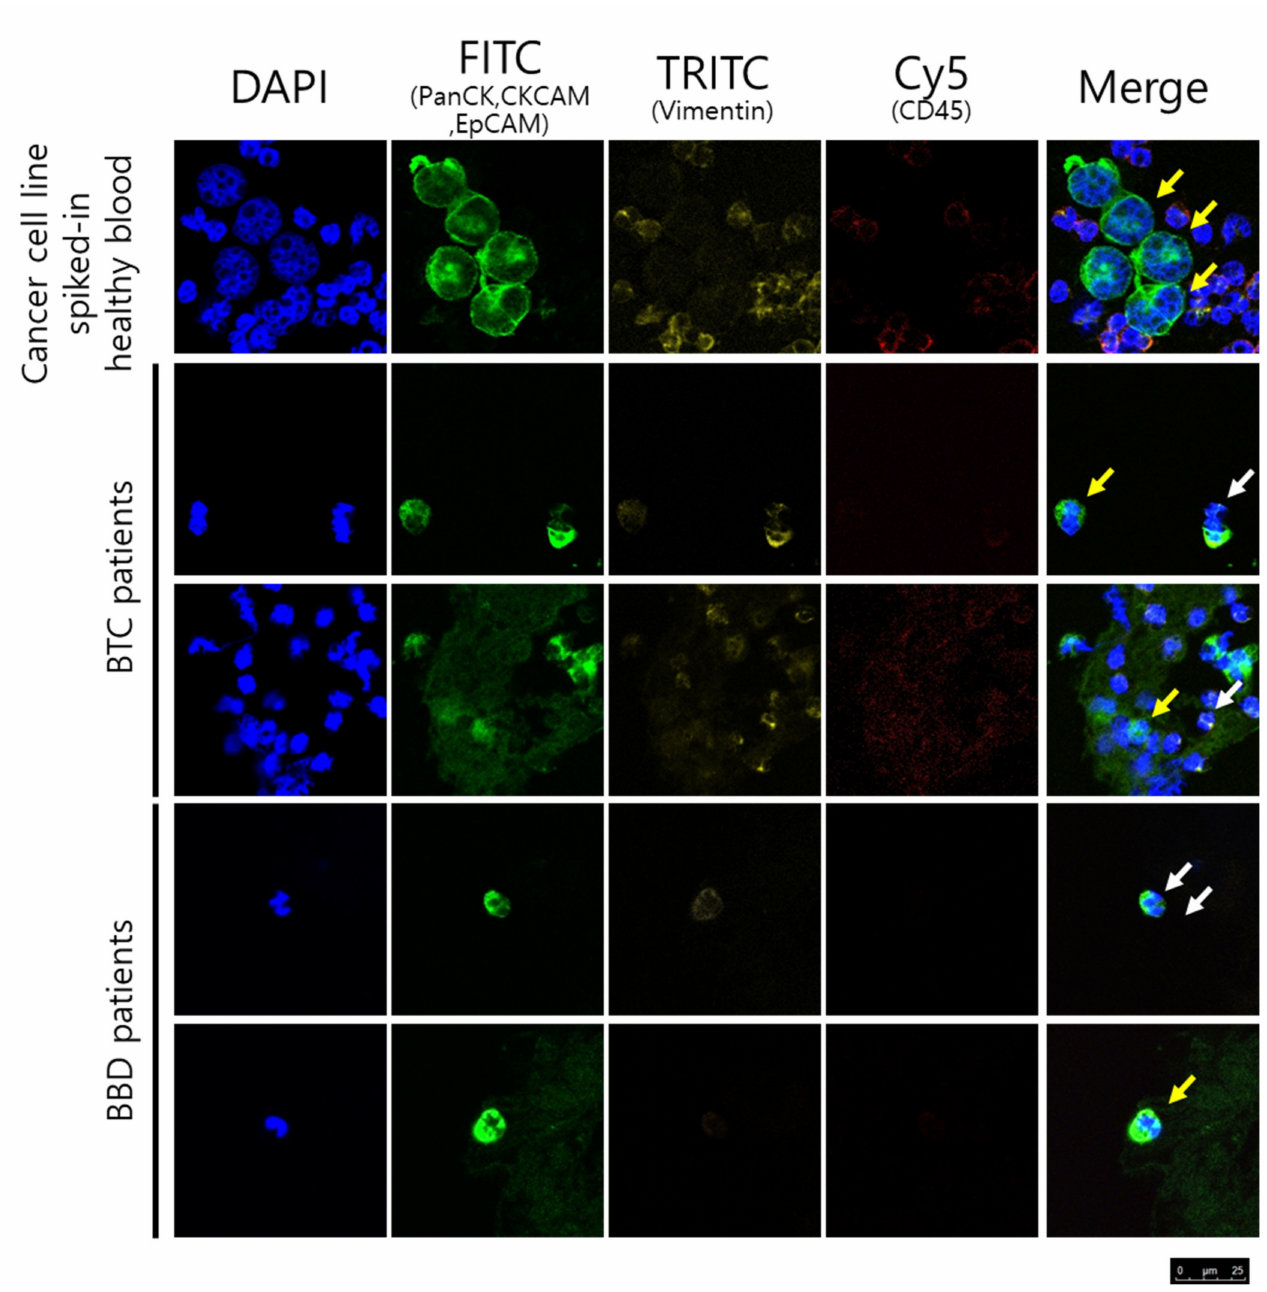
Figure 2. The yellow arrows indicate CTCs (PanCK+/CKCAM+/EpCAM+/CD45-) and white arrows indicate V-CTCs (PanCK+/CKCAM+/EpCAM+/CD45-, vimentin+) in BTC and BBD